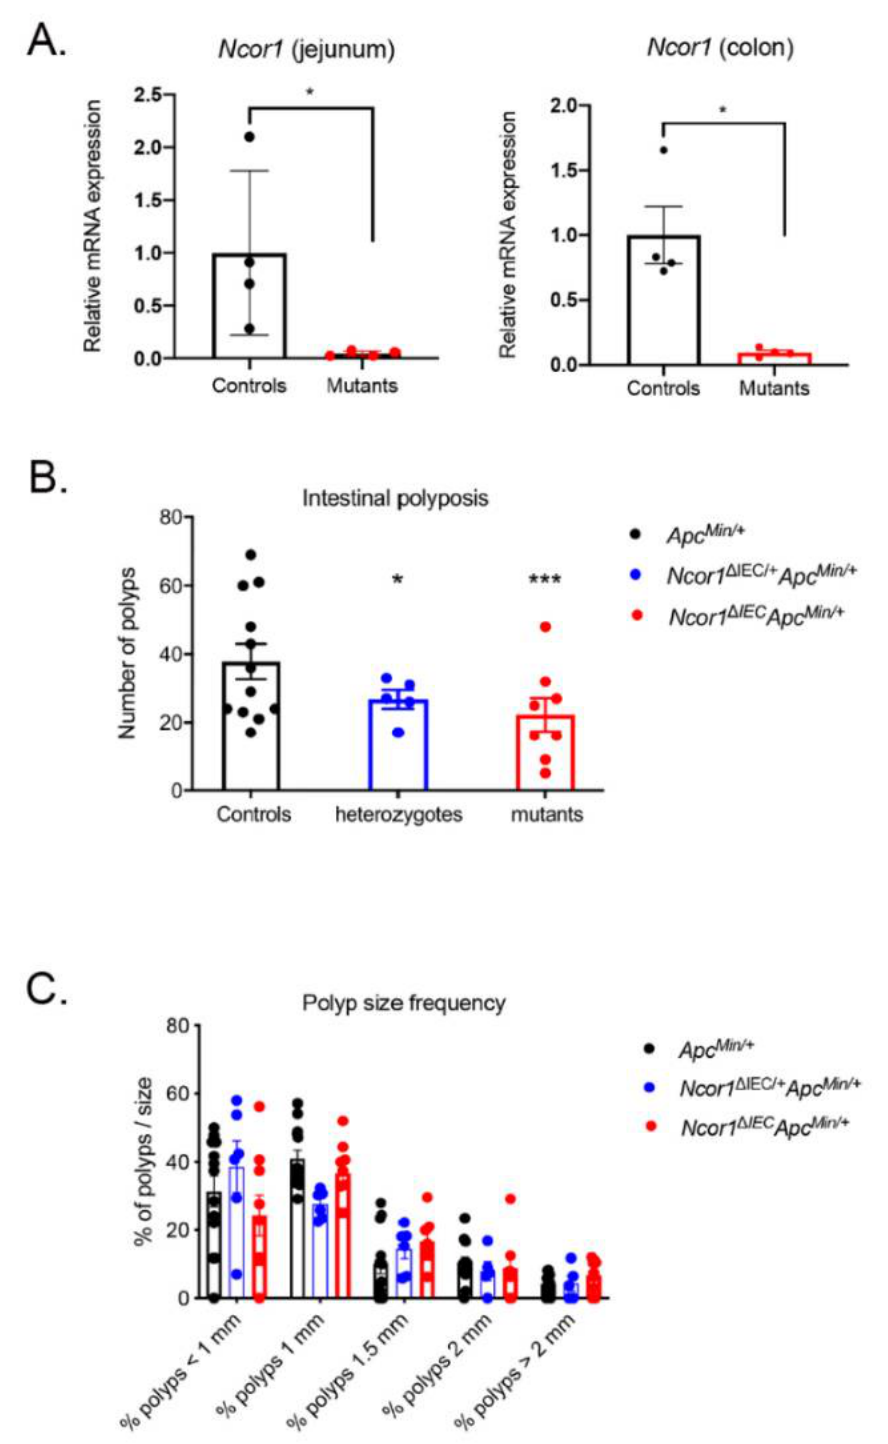
Figure 1. Ncor1 epithelial deletion reduces polyposis in Apc Min/+ mice. ( A ) Validation of the efficiency of Ncor1 conditional intestinal deletion in mice by qRT-PCR analysis. Ncor1 transcript expression was measured from the total RNA isolated from adult Ncor1 ∆ IEC and control mice ( n = 4; means ± SEM). Tbp gene transcript levels were used as reference. Student’s t -tests were used to measure the significance of the results (* p < 0.05). Total polyp macrocount ( B ) and polyp size distribution ( C ) in the whole intestine of adult Apc Min/+ ; Ncor1 ∆ IEC (mutants, n = 9), Apc Min/+ ; Ncor1 ∆ IEC/+ (heterozygotes, n = 6), and Apc Min/+ ; Ncor1 (control, n = 13) littermate mice. Data are presented as means ± SEM. Two-way ANOVA tests coupled with the Grubbs test were performed to measure the significance of the results (* p < 0.05; *** p <